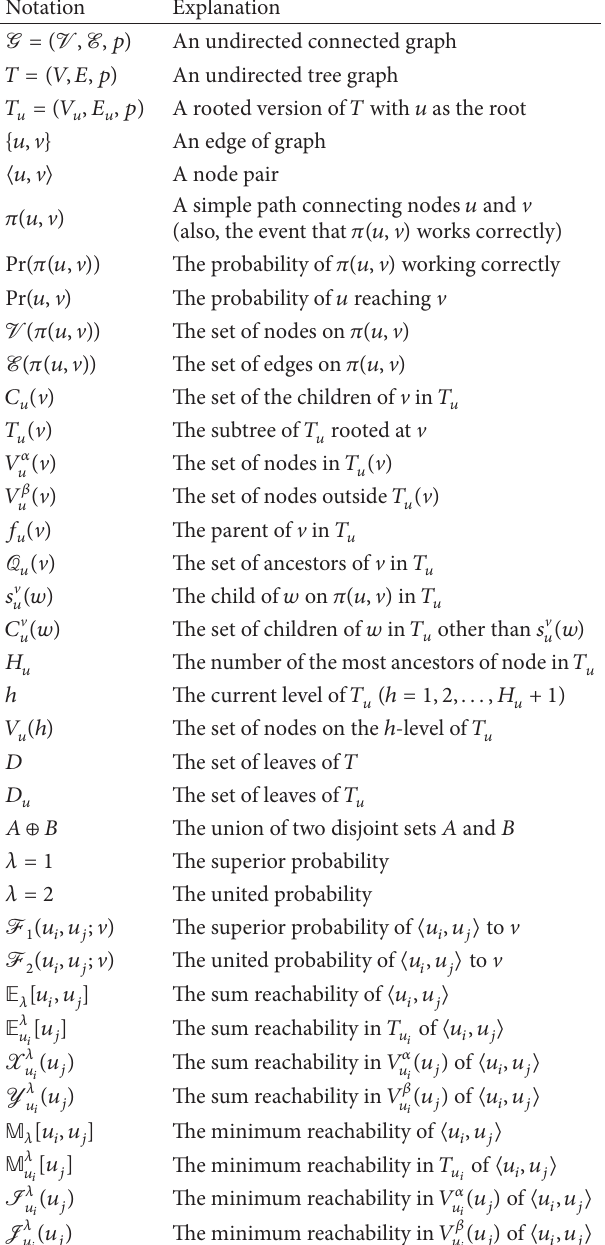
Table 2: Notations